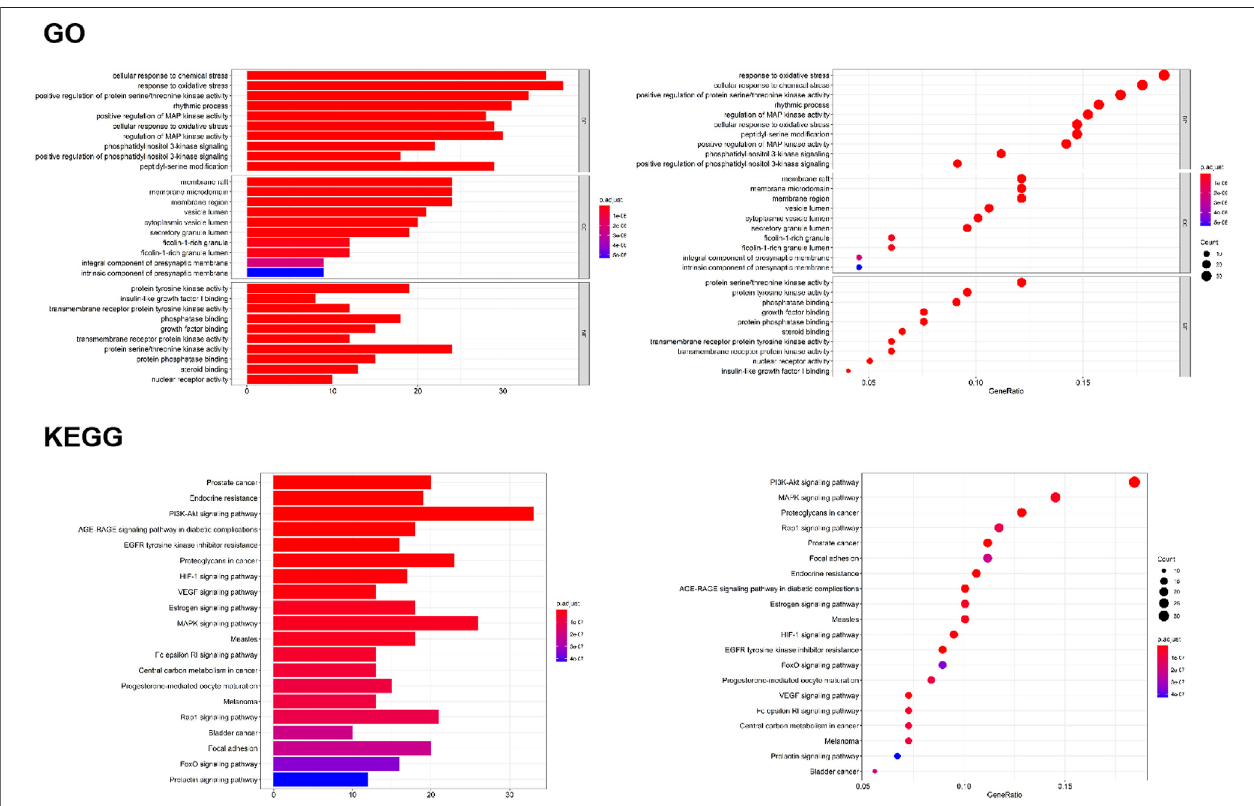
FIGURE 7 | GO analyses of the 198 gene symbols associated with RA. [The x-axis showing the signi fi cant enrichment in the counts of these terms. The y-axis showingthecategoriesof “ biologicalprocess ” intheGOofthetargetgenes( p < 0.01)];KEGGpathwayenrichmentanalyses[TheX-axisshowingthecountsofthetarget symbols in each pathway; the Y-axis showing the main pathways ( p <